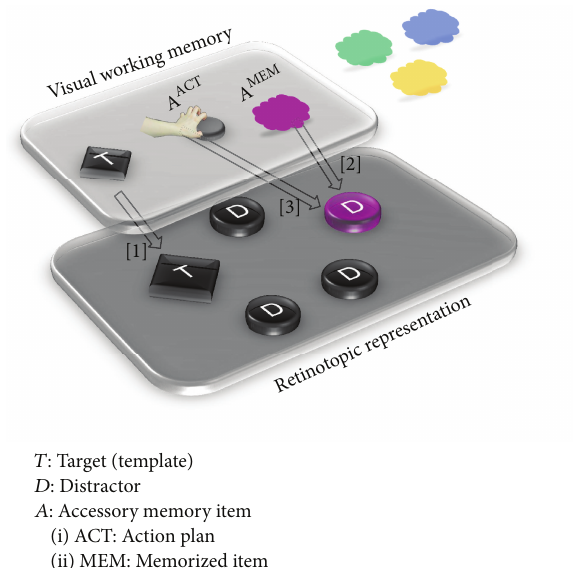
Figure 4: Potential extension of a visual working memory (WM) model suggested by Olivers et al. [13] to account for the interactions between working memory and action planning in the present study. A representation of the target ( 𝑇 ) is kept in WM in form of a search template that facilitates finding targets in visual search displays [1] . Accessory memory items ( 𝐴 ) are representations of objects that are in principle accessible to the visual system but are currently not relevant for the task. In the current study, accessory memory items are color hues to be remembered at the end of a trial but completely irrelevant in the search task ( 𝐴 MEM ). In “memorized color” trials they can impair search performance by enhancing an irrelevant distractor ( 𝐷 ) that shares their color category [2] . Our data suggest that distraction from target by objects of memorized colors is more pronounced when a grasping (rather than a pointing) movement is beingprepared.Wehypothesizethatmaintenanceofinformationfor subsequent action execution (“action plan”) induces an accessory memory item for action relevant features ( 𝐴 ACT ). As the to-be- grasped object is a circle, circular distractors with memorized colors receive further enhancement, thus increasing further interference with the target [3]